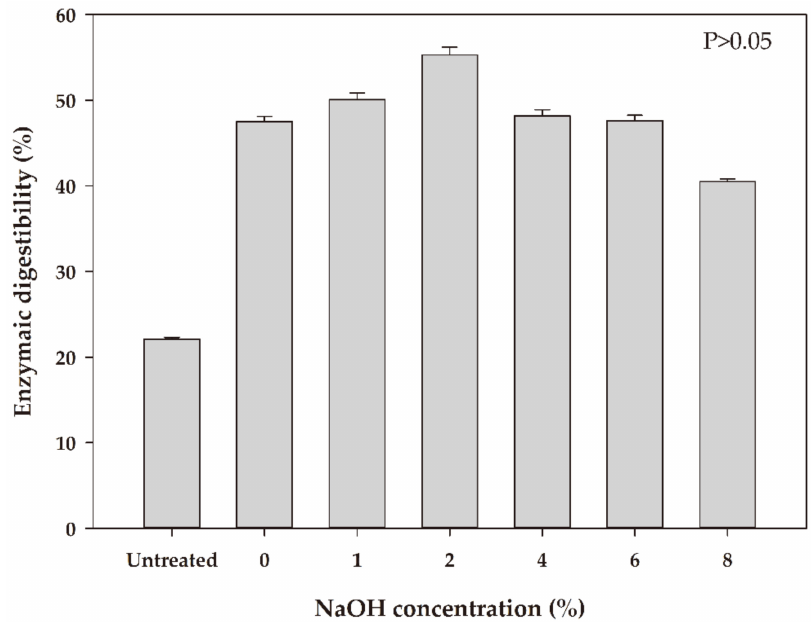
Figure 2. Enzymatic digestibility after pretreatment of Sicyos angulatus with different concentrations of NaOH at 121 ◦ C for 10 min.